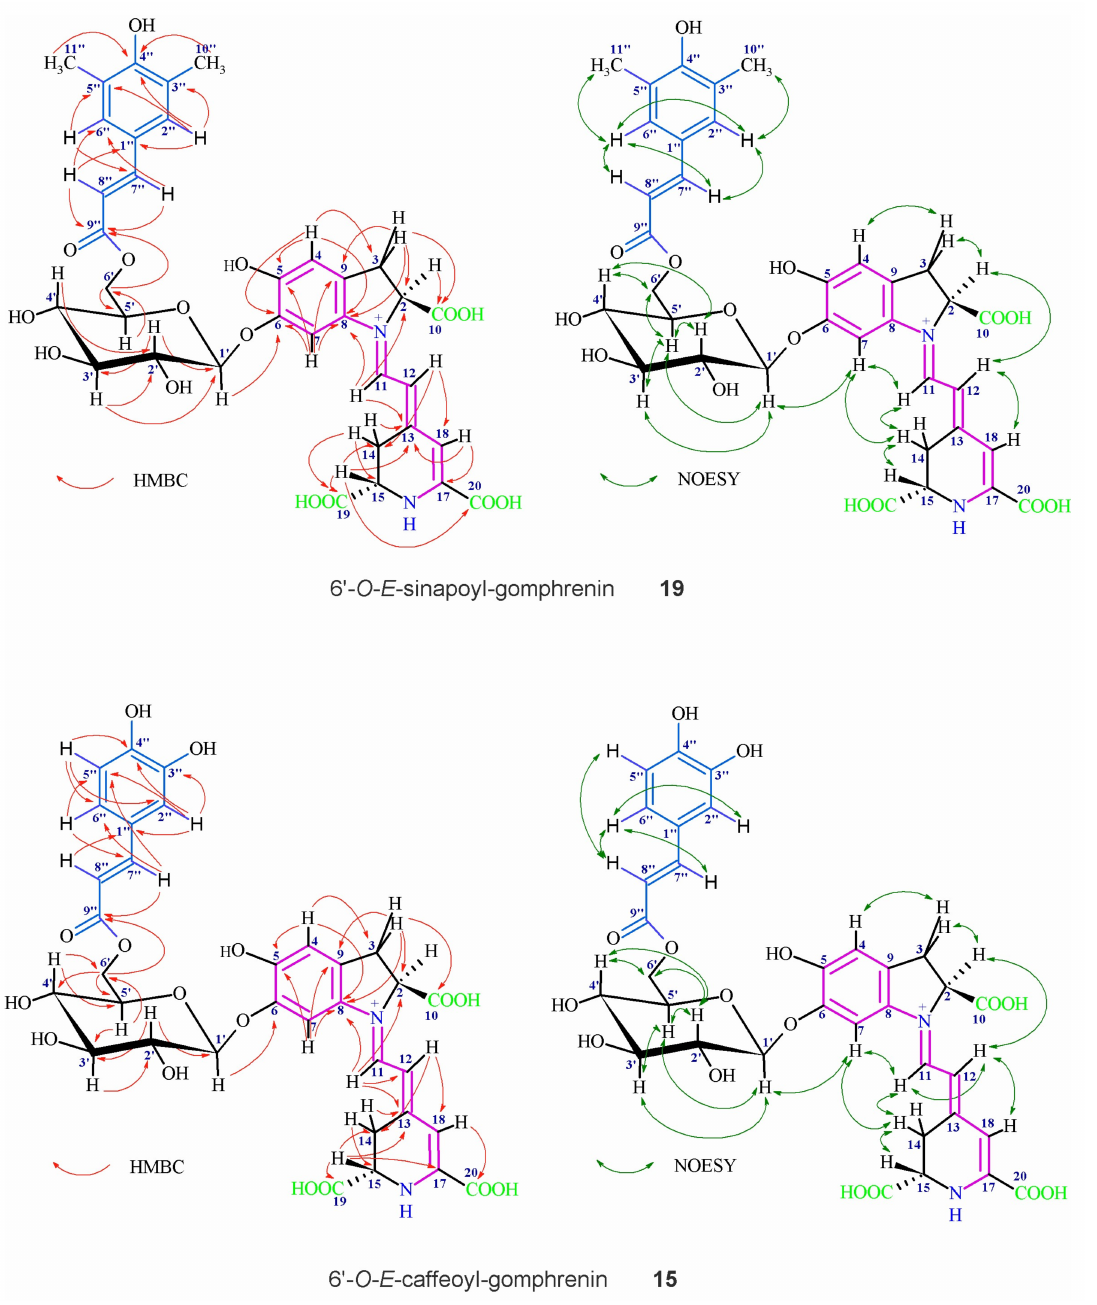
Figure 4. Important HMBC and NOESY NMR correlations indicating the structures of the chro- mophoric systems and the positions of the glycosidic bonds as well as the acyl moieties in the novel be- tacyanins: 6 (cid:48) O - E -caffeoyl-gomphrenin (malabarin) 15 and 6 (cid:48) O - E -sinapoyl-gomphrenin (gandolin) 19